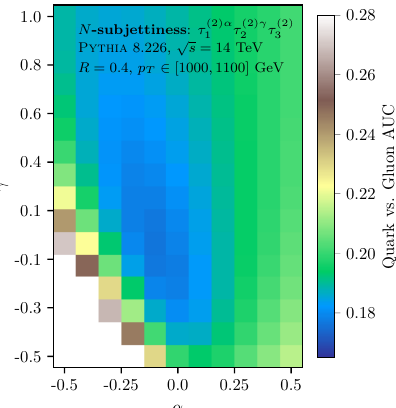
Figure 12. The AUC quark vs. gluon discrimination performance of N -subjettiness product ob- servable = (cid:28) (cid:11) (cid:28) (cid:13) (cid:28) 3 , sweeping over di(cid:11)erent parameter values. We see good qualitative agreement 1 2 O with the predictions shown in (cid:12)gure